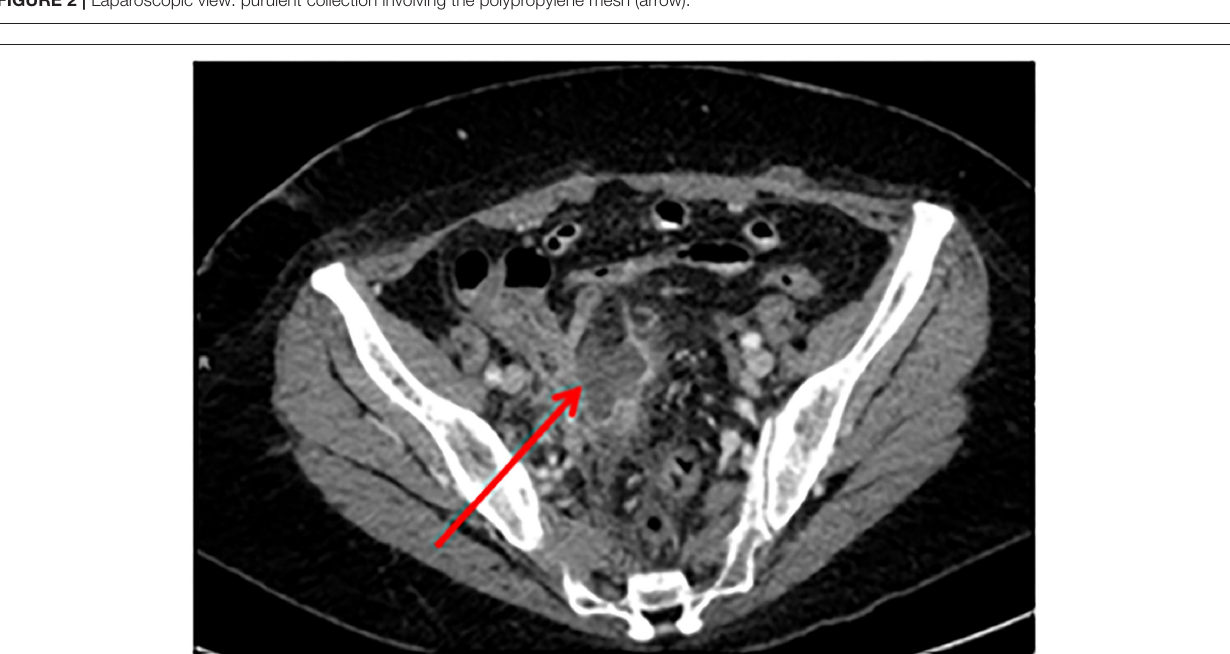
FIGURE 3 | CT: purulent collection of the pelvis between the vagina and the rectum (arrow). CT, computed